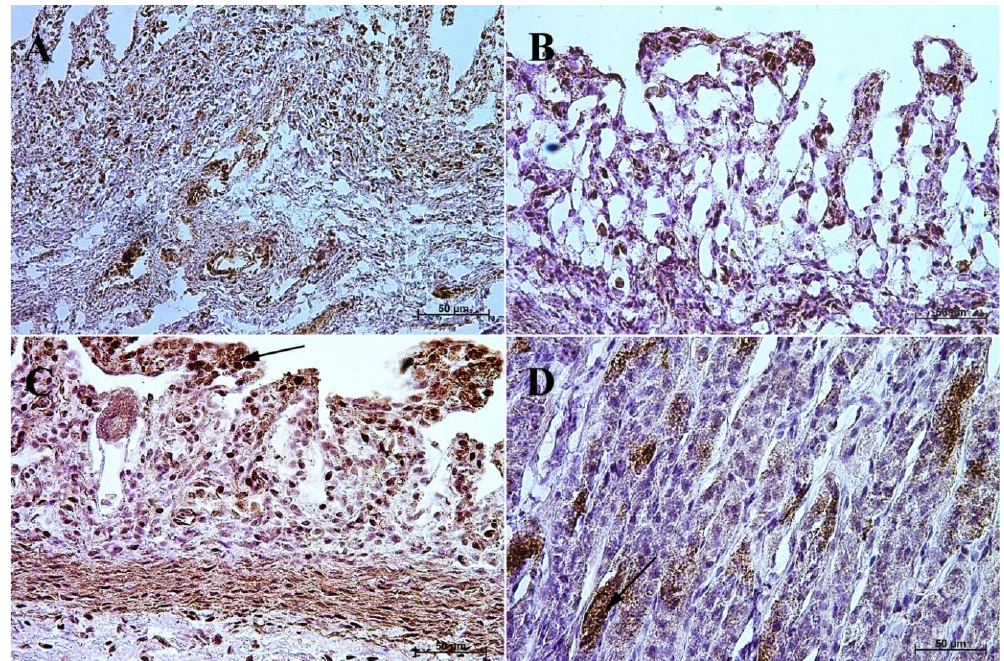
Figure 9. Immunoreactivity of anti-somatostatin antibody in the fundic mucosa, 40×. ( A ) the first age group, ( B ) the second age group, ( C ) the third age group, ( D ) adult reference group. The arrow indicates positive immunohistochemical reaction.